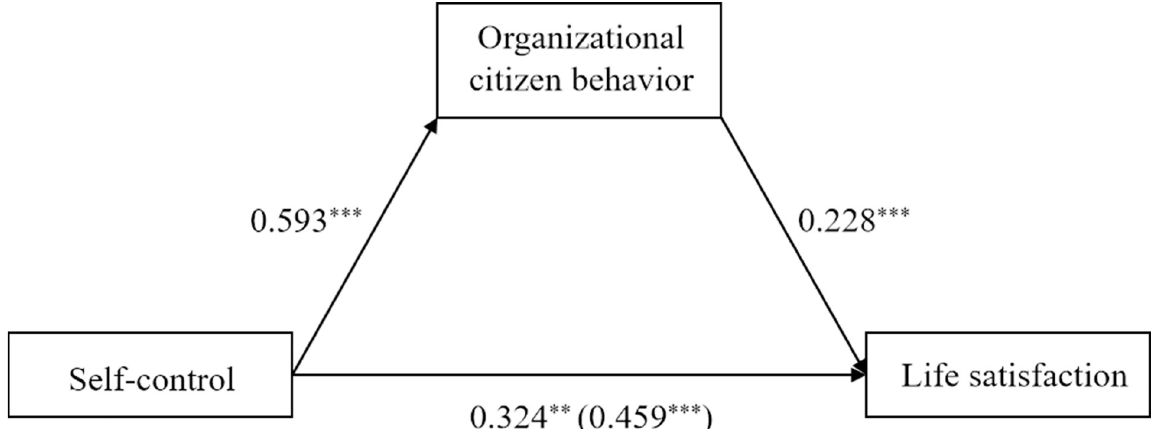
Fig 4. Mediation of organizational citizen behavior between self-control and life satisfaction in employees (sample 3). �� p < 0.01, ��� p < 0.001; value in parenthesis represents total effect.